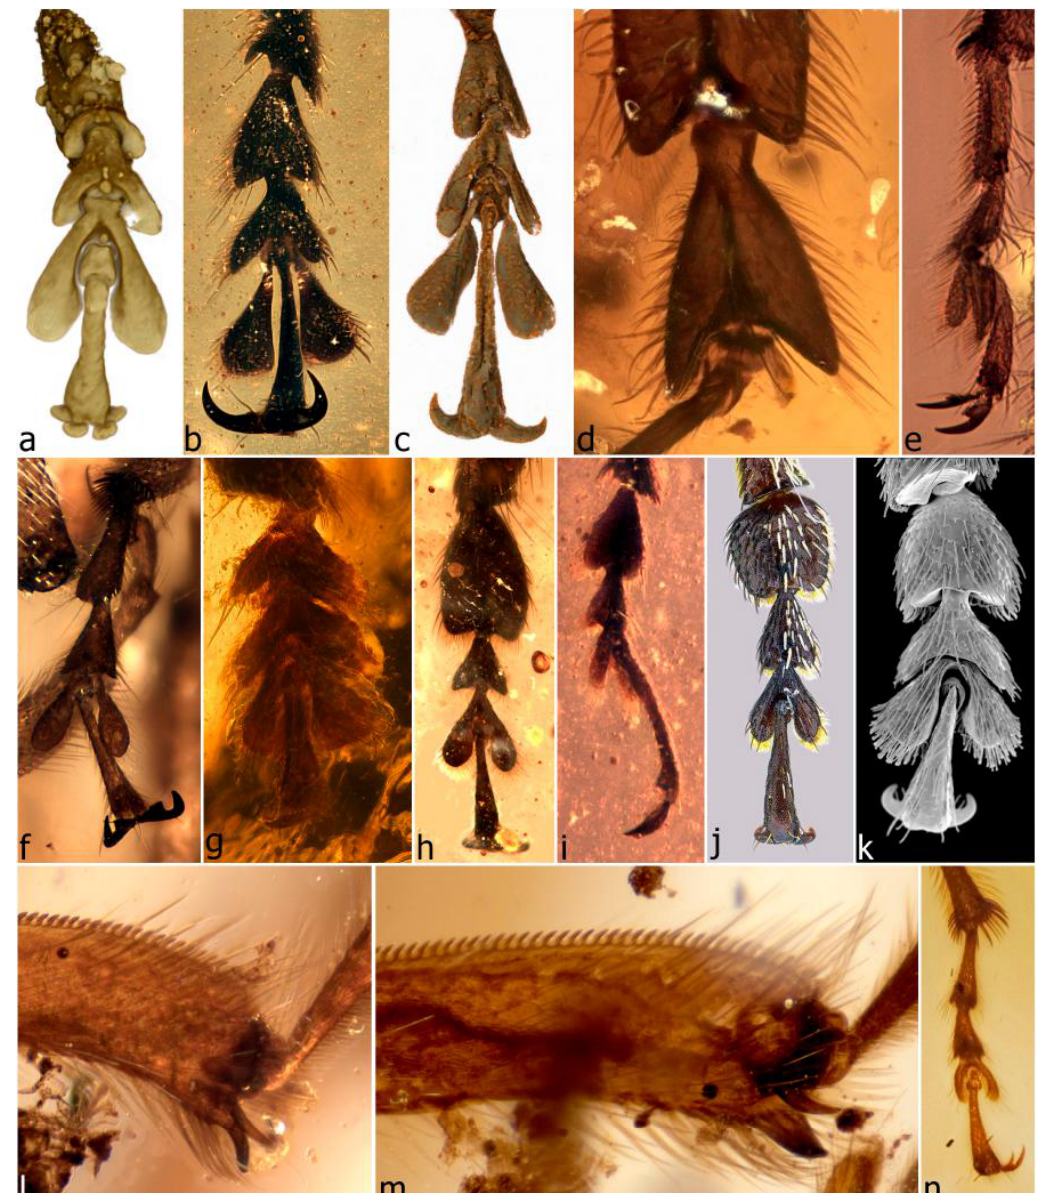
Figure 11. Tarsi in Mesophyletidae and some extant weevils. Calyptocis brevirostris , mesotarsus (CT scan) ( a ); Opeatorhynchus comans , protarsus (ventral view) ( b ); Cetionyx batiatus , protarsus (CT scan) ( c ); Echogomphus viridescens , protarsus ( d ); Habropezus incoxatirostris , protarsus, lateral view ( e ); Myanmarus caviventris , protarsus ( f ); Petalotarsus oxycorynoides , protarsus ( g ); Platychirus brevirostris , mesotarsus ( h ); Burmorhinus setosus , mesotarsus ( i ); Stenobelus testaceus (Belidae), protarsus ( j ); Car cf. condensatus (Caridae), metatarsus ( k ); Elwoodius conicops , mesotibial apex with fixed inner spur ( l ); Elwoodius conicops , metatibial apex with fixed inner spur ( m ); Burmonyx zigrasi (Nemonychidae), left metatarsus (dorsal view) ( n ).